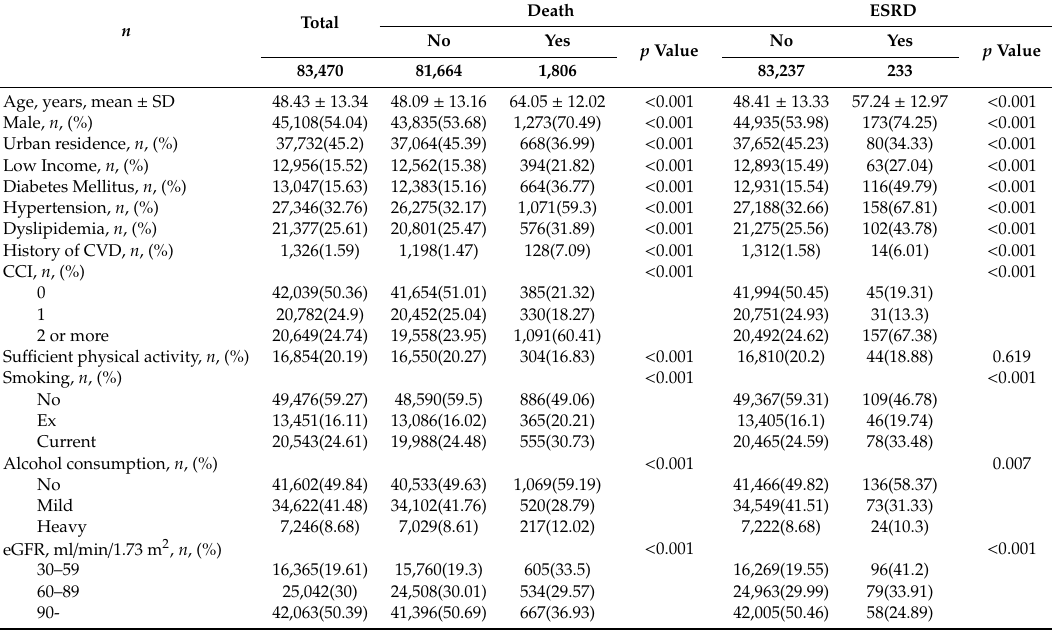
Table 1. Baseline characteristics of study